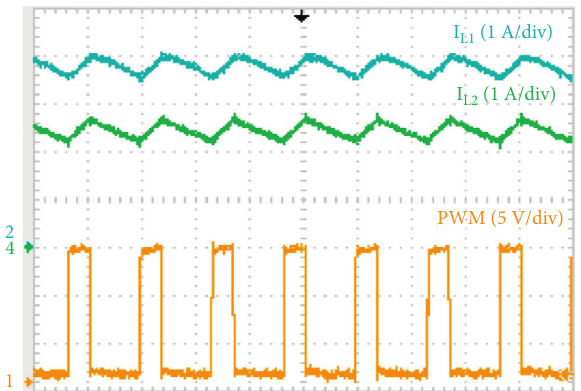
Figure 21: Boost mode operation of the converter: switching PWM (channel 1); I